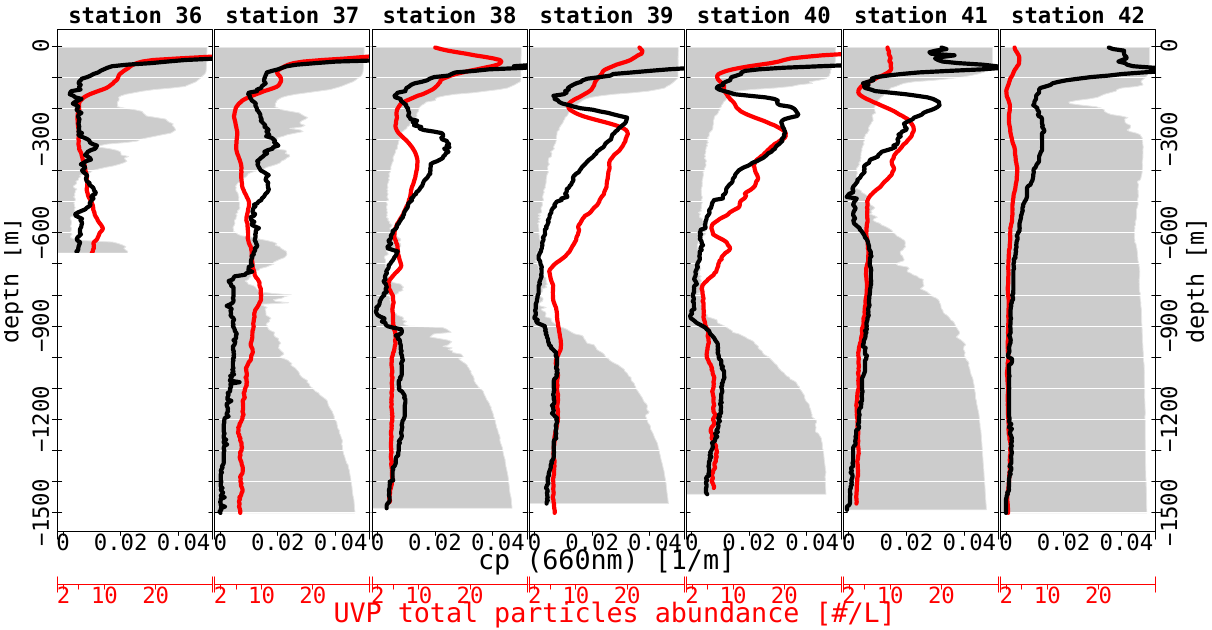
Figure 8. Vertical profiles of SPM ( c p , black curves) and total LPM (UVP total particles abundance, red curves) with oxygen concentration background (grey colour, for units see Fig. 4). The INL and DNL can be observed with peaks at 300 and 900m depth respectively. Total LPM mainly represents the smallest particle size classes given their